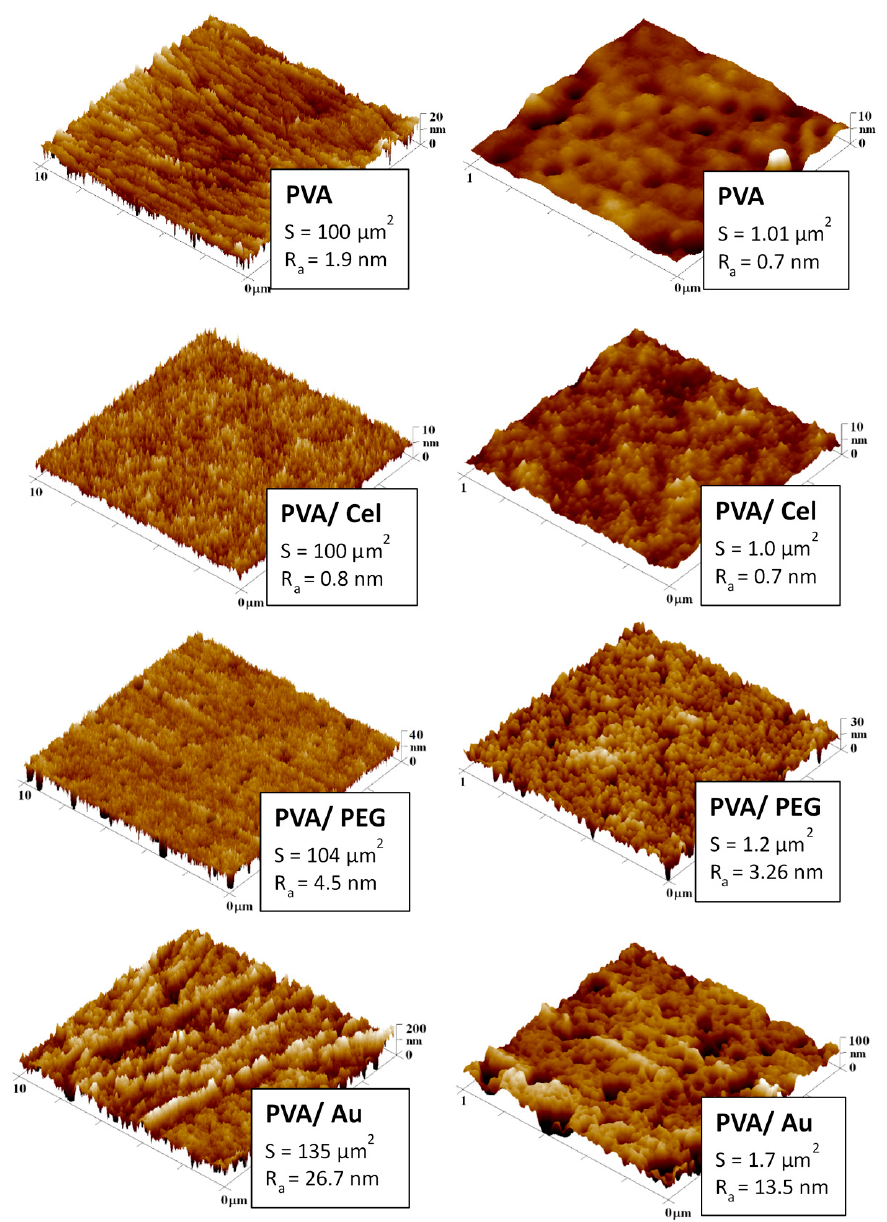
Figure 3. AFM images of pristine non-doped PVA and PVA doped with cellulose (PVA/Cel), poly(ethylene glycol) (PVA/PEG) and Au nanoparticles in a PEG colloid solution (PVA/Au). The column on the left column represents regions of 10 μ m ×10 μ m, and the column on the right represents regions of 1 μ m ×1 μ m. R a is the average surface roughness in nm, S corresponds to the effective surface area.